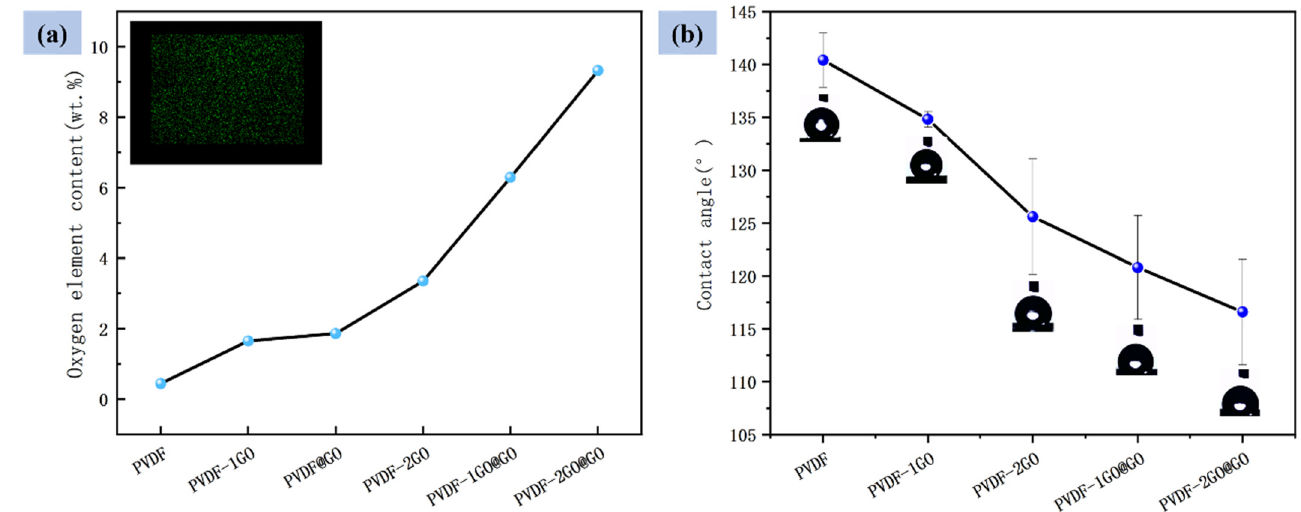
Figure 4. ( a ) Oxygen element content and ( b ) water contact angle of different nanofibers.